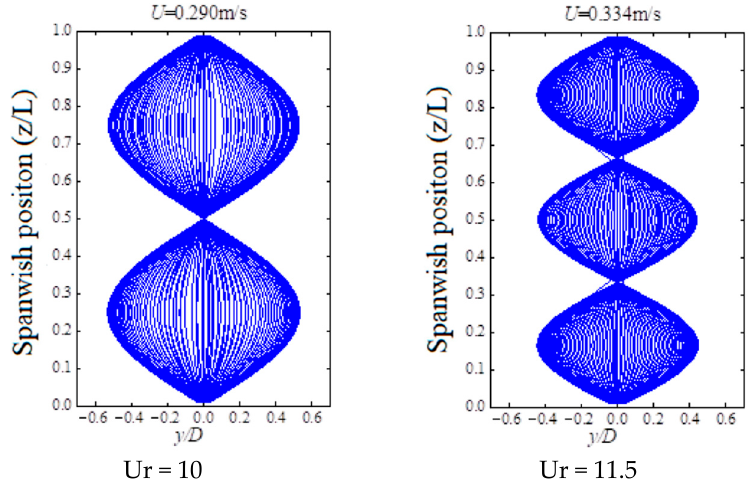
Figure 11. Displacement Modal Response of No. 4 Tension Leg at 0° Inflow Angle and Different Flow Velocity.